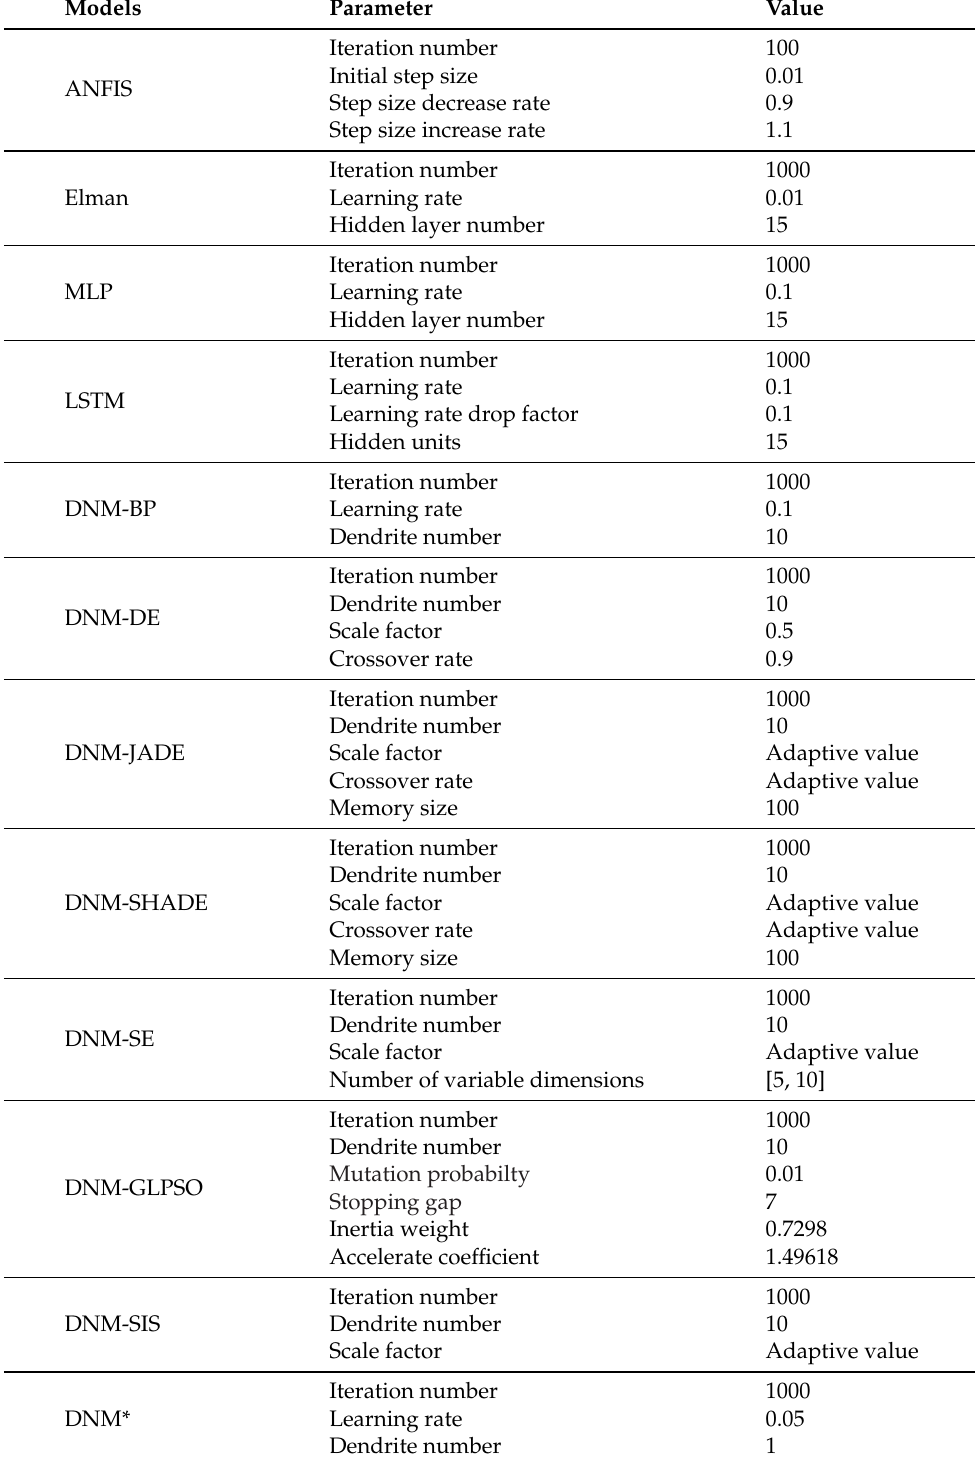
Table 3. Parameter settings of the prediction models on the five stock price index